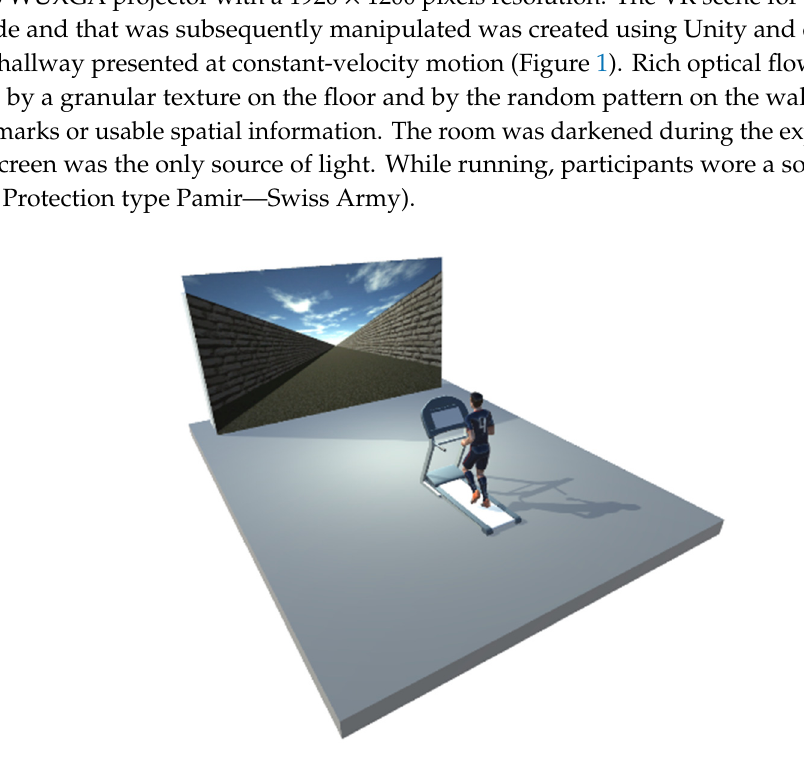
Figure 1. Experimental setup.